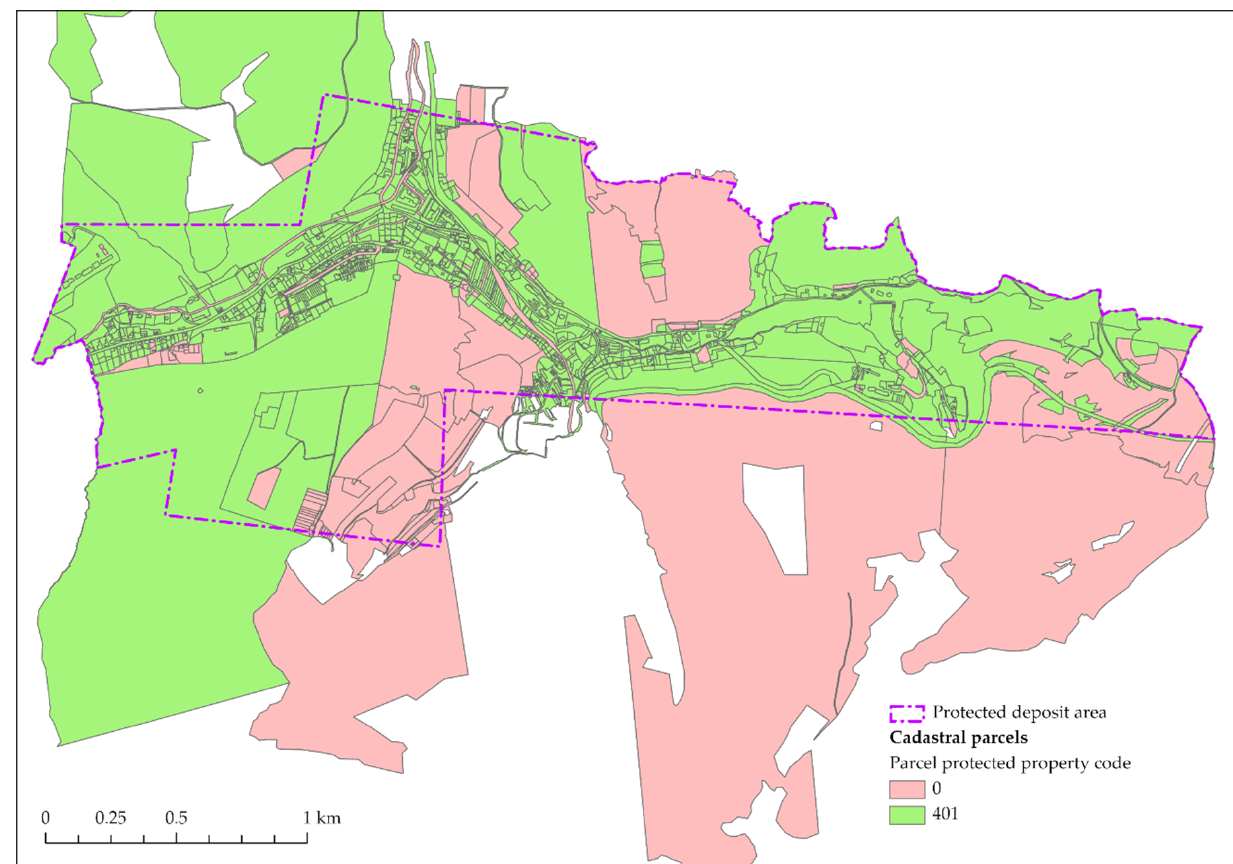
Figure 9. Graphical representation of “401” PDA code information on parcels in the c.u. Rud ň any.